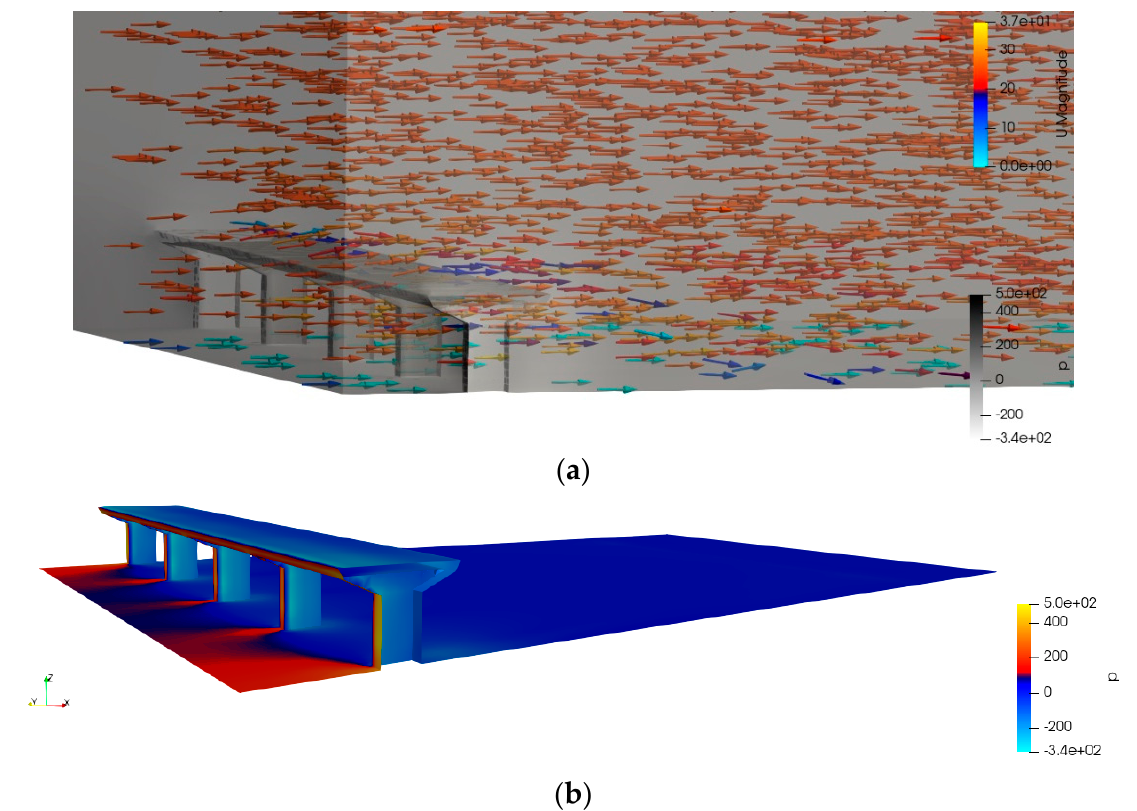
Figure 3. Results from CFD modelling: ( a ) Pressure on the bridge in black and white, and the velocity magnitude and direction in the form of coloured arrows; Velocity magnitude and direction of the wind flows around the bridge( b ) pressure on the bridge in colour; Pressure acting on the bridge. Figure 4 plots the wind force against wind direction for the bridge deck in the x-direction and the z-direction and the piers in the x-direction. Each point on a graph represents a simulation that was performed: red circles for Cork, blue diamonds for Dublin and green squares for Galway. In Figure 4a, there appear to be negligible differences between the net wind force values for the 180 ◦ and 300 ◦ wind directions and the 210 ◦ and 270 ◦ wind directions, as the wind direction is changed by rotating the geometry of the bridge within the CFD model and not through the skewed Eurocode directional factors. It is interesting to note that the Galway wind force values are lower than those in Dublin and Cork, which is likely due to its lower altitude. Similar trends are apparent in Figure 4b for the deck in the z-direction. Interestingly, the shape trend for the piers in the x-direction is inverted. This is likely an effect of rotating the geometry of the piers in the CFD model; the more the wind is rotated away from the direction that is perpendicular with the piers, the more area of the piers the wind will come into contact with. This is especially true given that unlike the deck, only the shorter dimension of the piers is exposed to wind travelling perpendicularly to the bridge deck, whereas both the shorter and longer dimensions are exposed to the other four wind directions. This is reflected in the wind directions 60 ◦ from the perpendicular direction. For example, the cases that are 180 ◦ and 300 ◦ clockwise from due north have the highest net wind force values. The cases with the wind directions 30 ◦ from the perpendicular direction, 210 ◦ and 270 ◦ clockwise from due north, have the second highest net wind force values. Finally, the perpendicular direction, 240 ◦ clockwise from due north, has the lowest net wind force